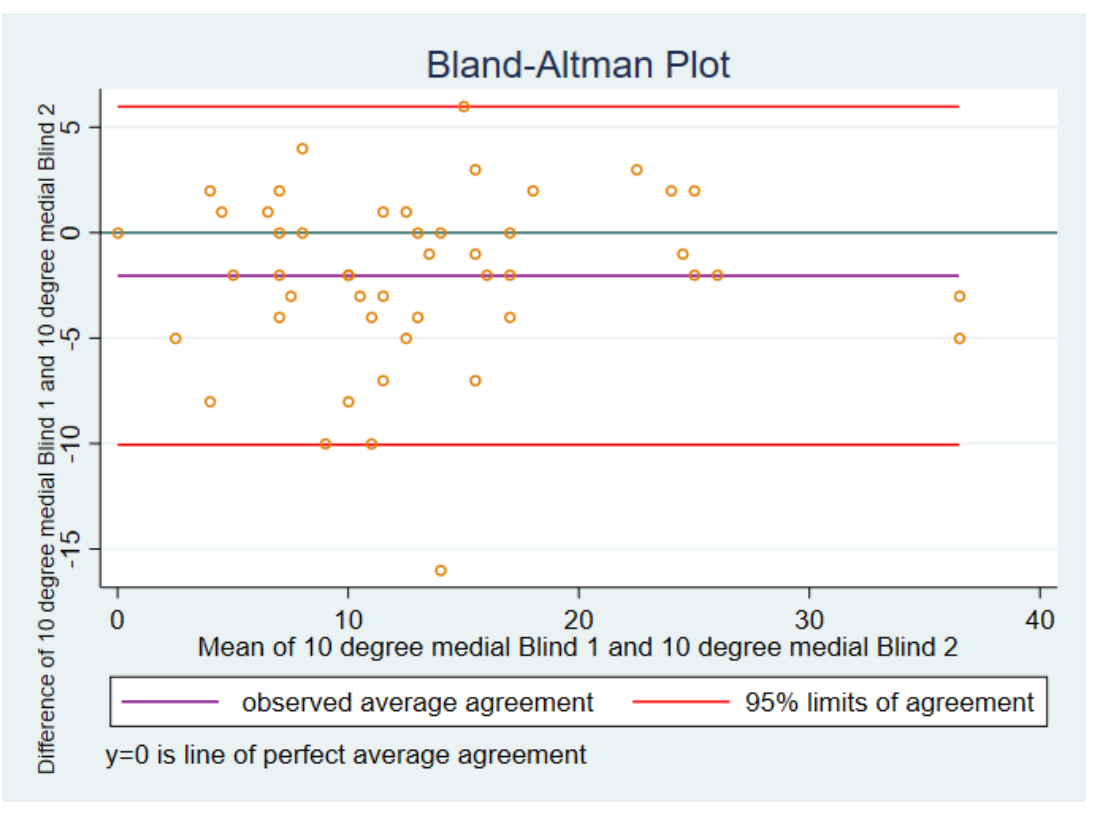
Figure 2. Ten degrees, medial.